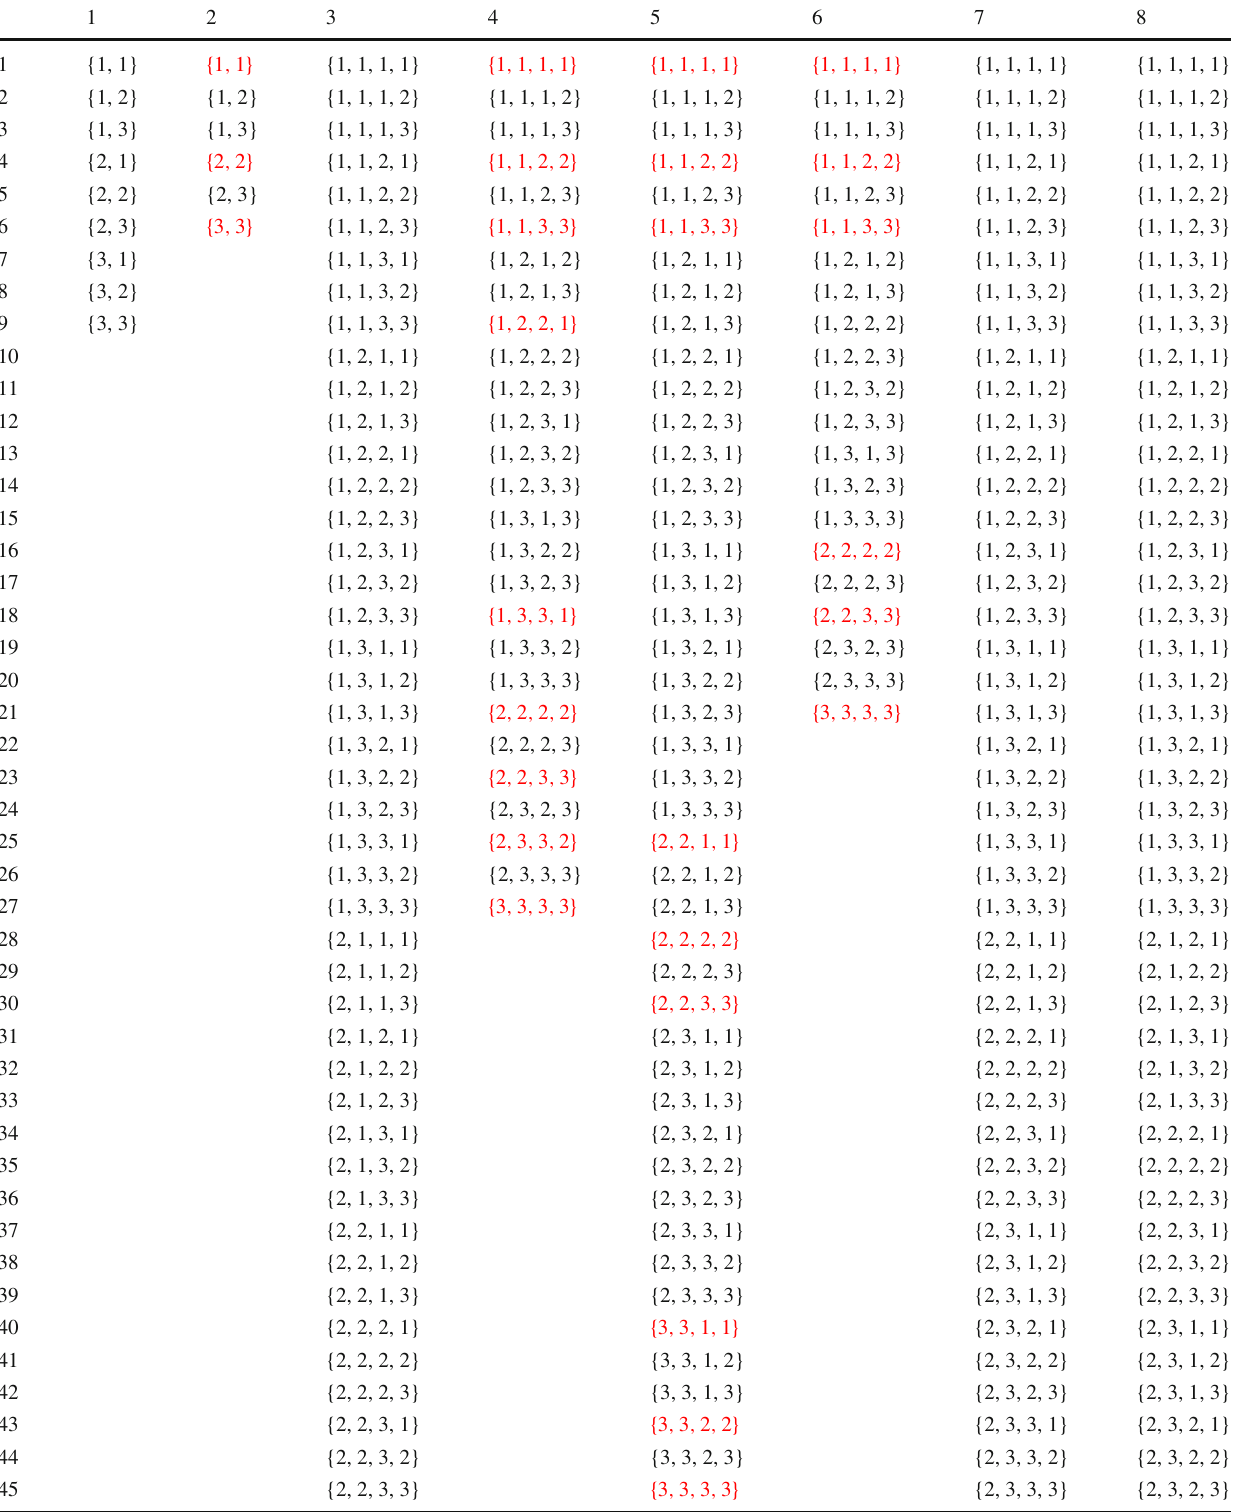
Table 7 Independent SMEFT WCs in each category. Elements in red denote real